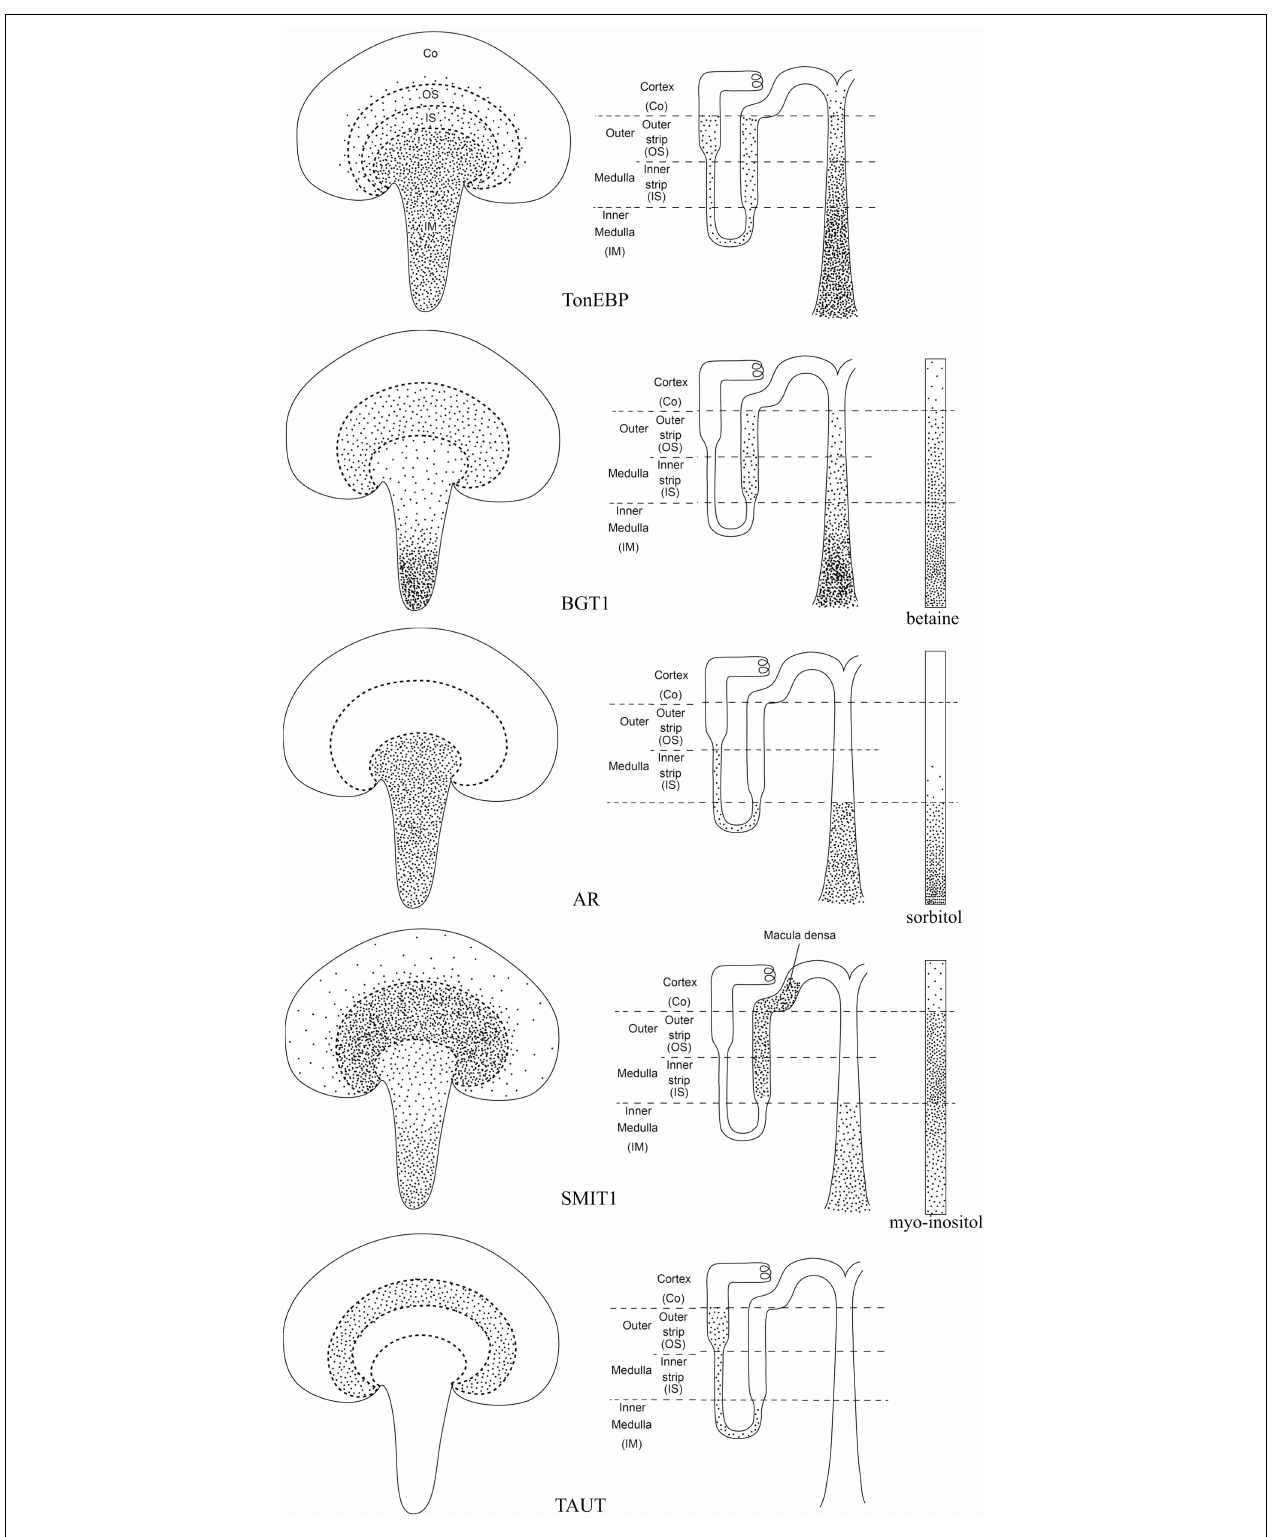
FIGURE 3 | Schematic illustration of the distributions of TonEBP, BGT1, AR, SMIT1, and TAUT as well as the related osmolytes in the kidney. TonEBP is present in most tubular profiles in the medulla, including the loop of Henle and medullary collecting ducts and interstitial cells (Han et al.,